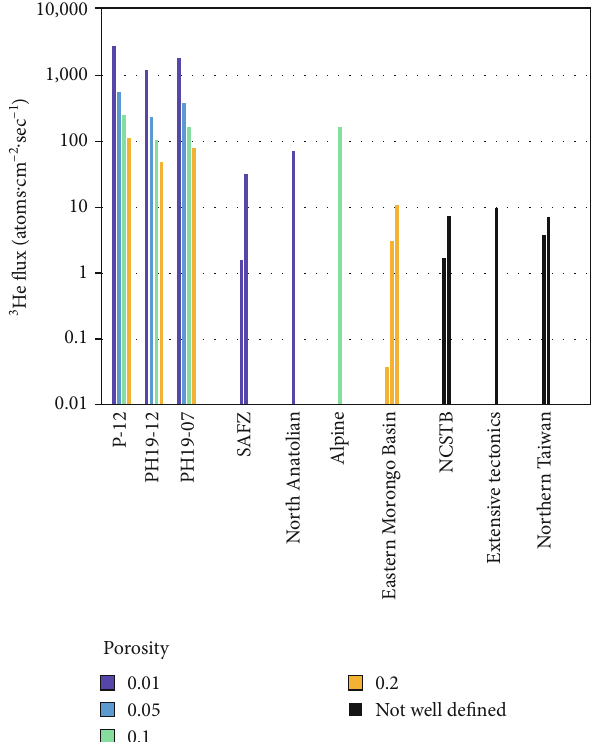
Figure 7: 3 He fl ux of the Heunghae (P-12), Namsong (PH19-12), and Jamyeong faults (PH19-07). Reference data from San Andreas Fault Zone (SAFZ, [50]), North Anatolian Fault[50], Alpine Fault [46], Eastern Morogongo basin [56], North-Central Sicilly thermal basin (NCStb) [57], extensive tectonics settings [22], and Northern Taiwan